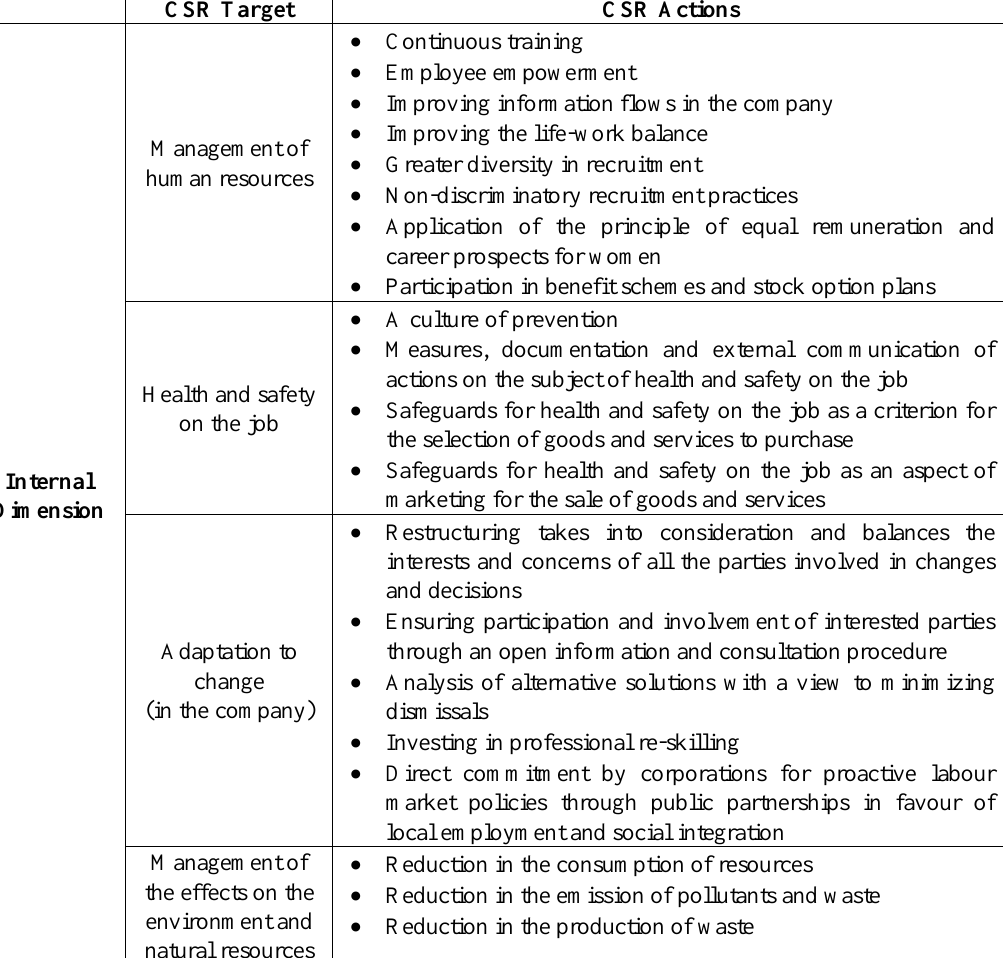
Figure 3: Corporate Social Responsibility: the Internal Dimension CSR